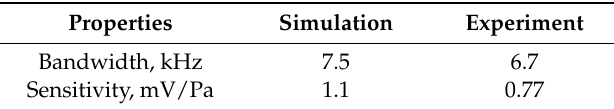
Table 4. Comparison of the simulation and experiment results.